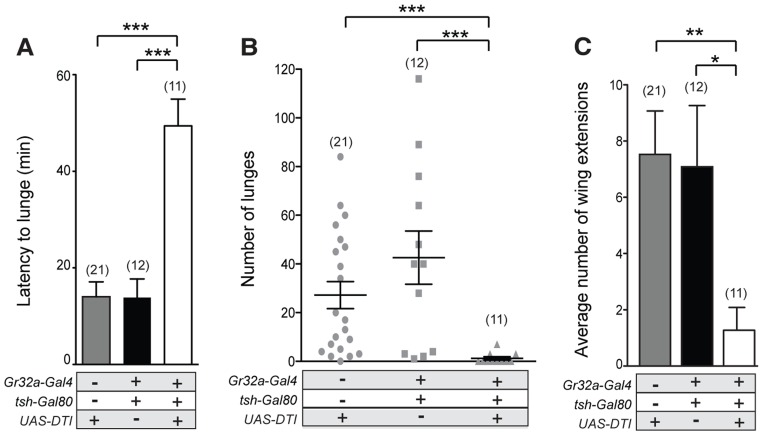
Gr32a chemosensory neurons located in the mouth promote aggression without an elevation in male-male courtship.(A–B) Fights between males with the Gr32a-expressing mouth neuronal population removed by expressing Diptheria Toxin (UAS-DTI) through the Gr32a-Gal4 line with Gal4 activity in the legs blocked by tsh-Gal80. Separate transgenic controls, UAS-DTI/+ and tsh-Gal80/+; Gr32a-Gal4/+ were scored. (A) The latency to first lunge was significantly higher in UAS-DTI/tsh-Gal80; Gr32a-Gal4/+ males as compared to controls (Kruskal-Wallis with Dunn's multiple comparison test, ***p<0.001). (B) Number of lunges performed per 30 min period after the first lunge by controls or experimental UAS-DTI/tsh-Gal80; Gr32a-Gal4/+ males. Each dot represents the numbers of lunges performed by either male in a fighting pair. Males without Gr32a-expressing mouth neurons exhibited a significant reduction in lunges as compared to controls (Kruskal-Wallis test with Dunn's multiple comparison test, ***p<0.001). (C) The average number of wing extensions directed toward the second male in each aggression assay. The number of wing extensions exhibited by males without mouth Gr32a neurons were less than control males (Kruskal-Wallis with Dunn's multiple comparison test, *p<0.05, **p<0.01). Error bars denote s.e.m.